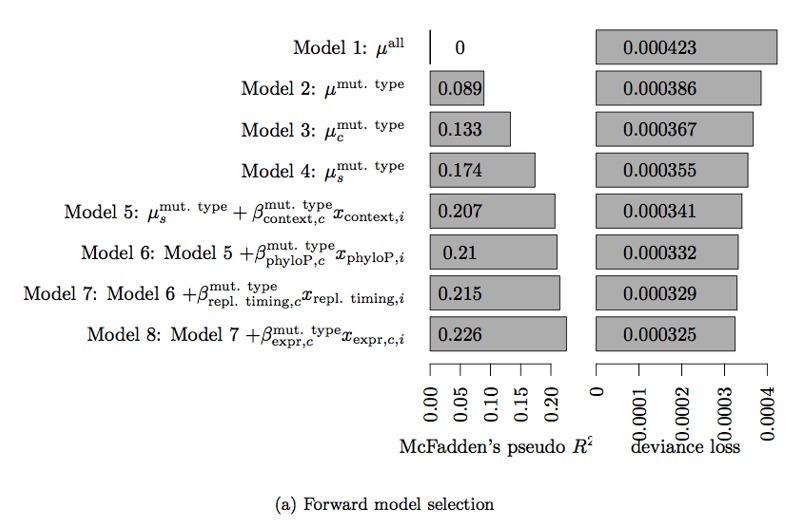
DOI:
http://dx.doi.org/10.7554/eLife.21778.049